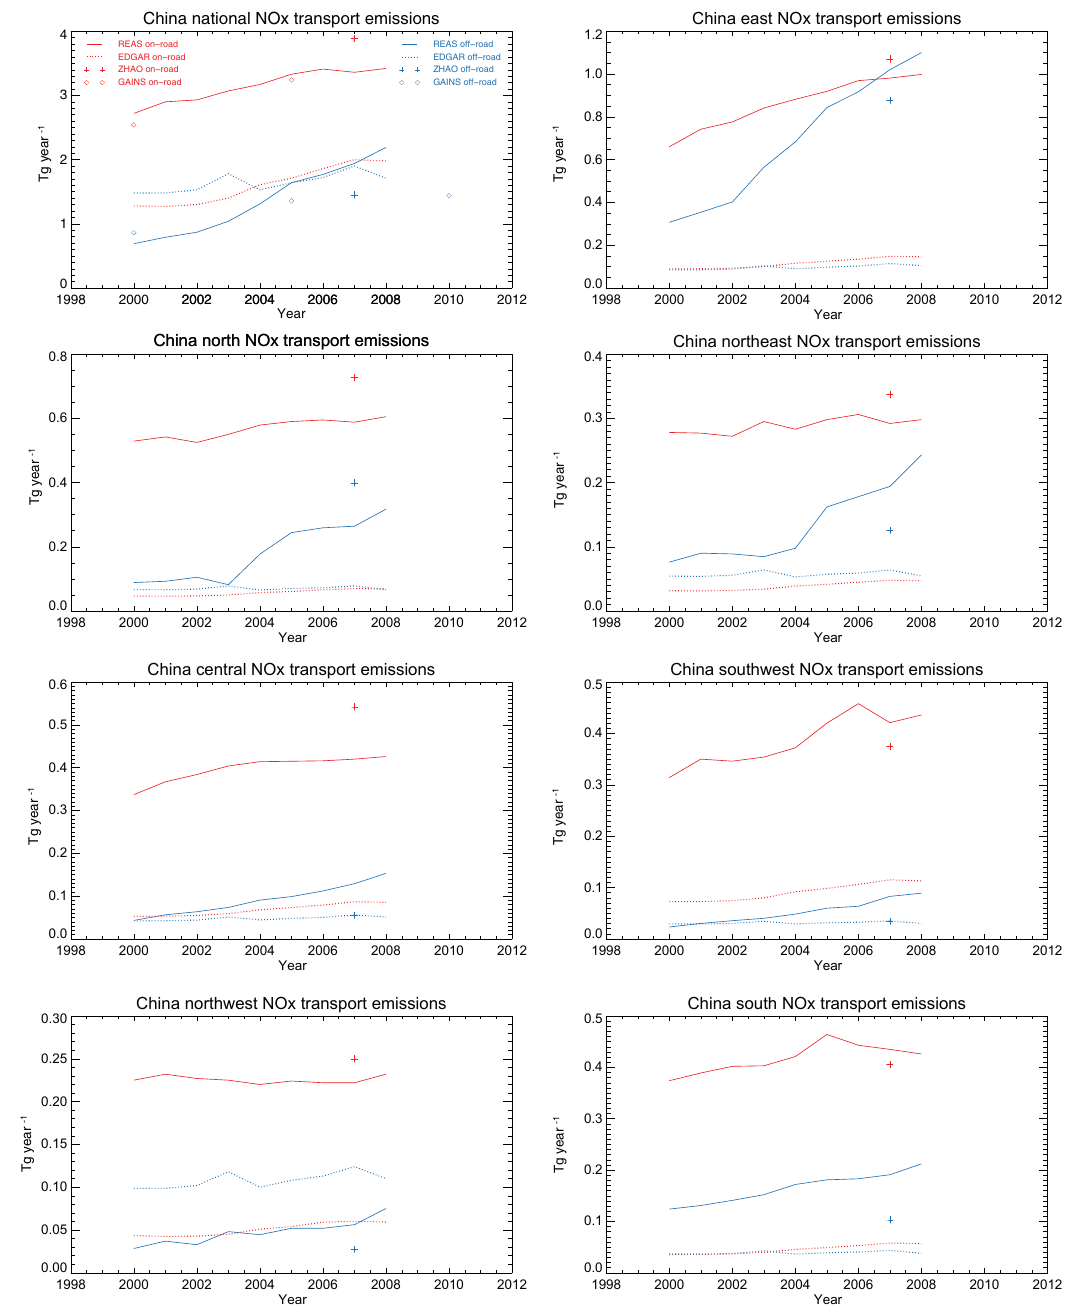
Figure 12. National and regional on-road and off-road transport sector emissions of NO x estimated by REAS, EDGAR, ZHAO, and GAINS between 2000 and